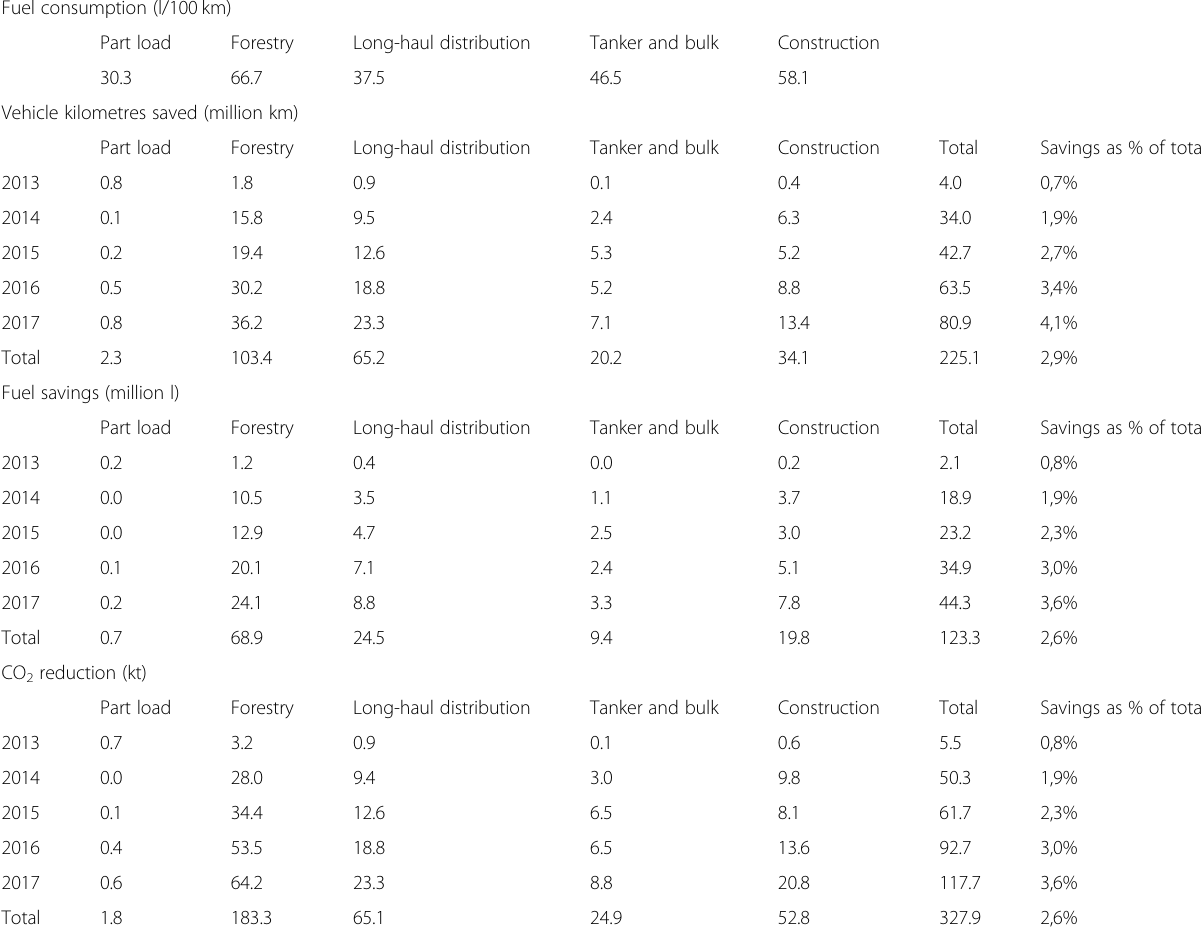
Table 6 Fuel and CO 2 savings of using HCVs in 2013 – 2017 Fuel consumption (l/100